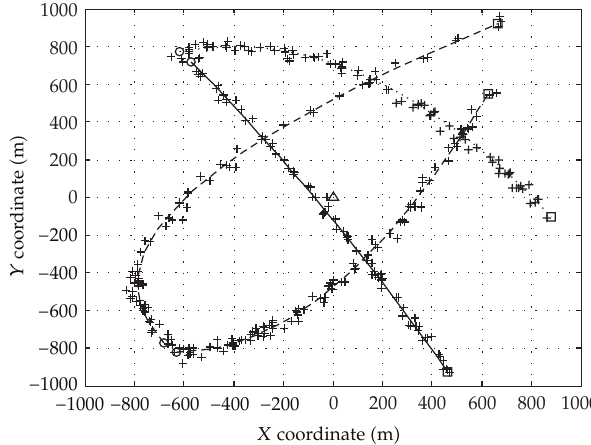
Figure 1: The true trajectories for extended targets and sensor